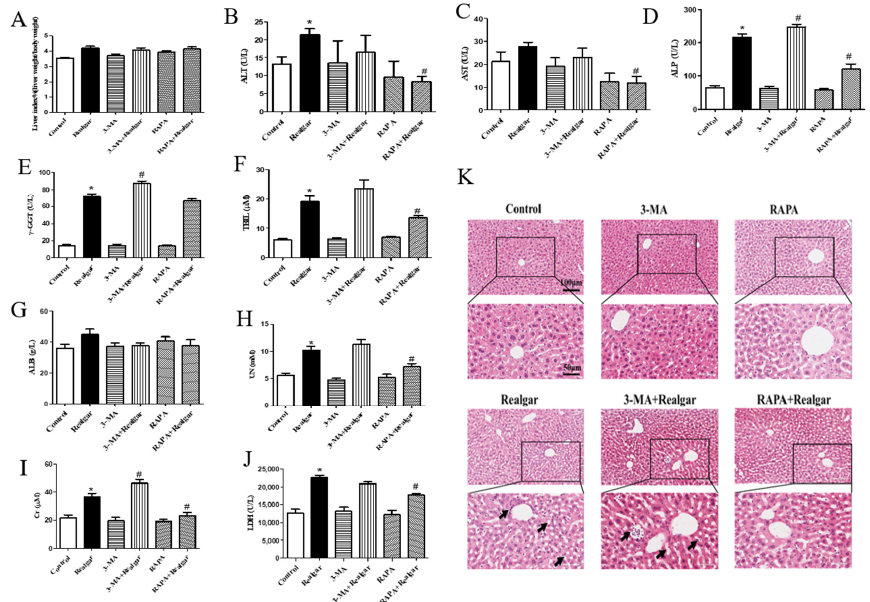
3.3. Autophagy Reduces Pro-Inflammatory Cytokines Expression and Release Induced by Realgar